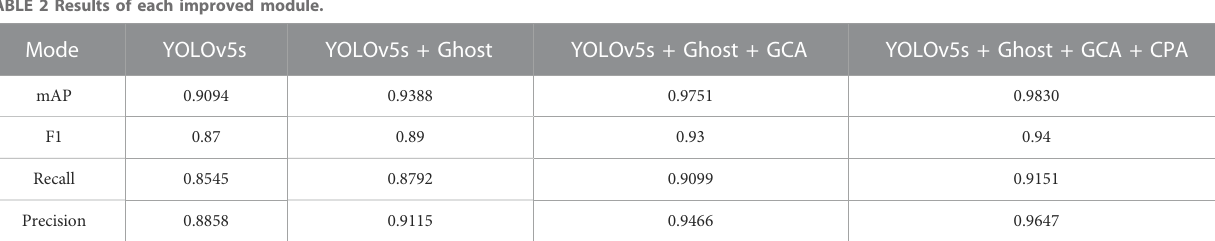
TABLE 2 Results of each improved